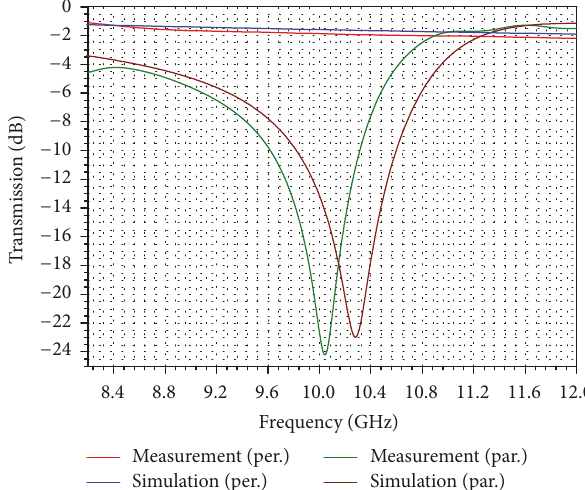
Figure 14: The circular electrically large metasheet in the 𝑥 - 𝑦 plane. Copper rings are placed on the FR4 substrate [8].